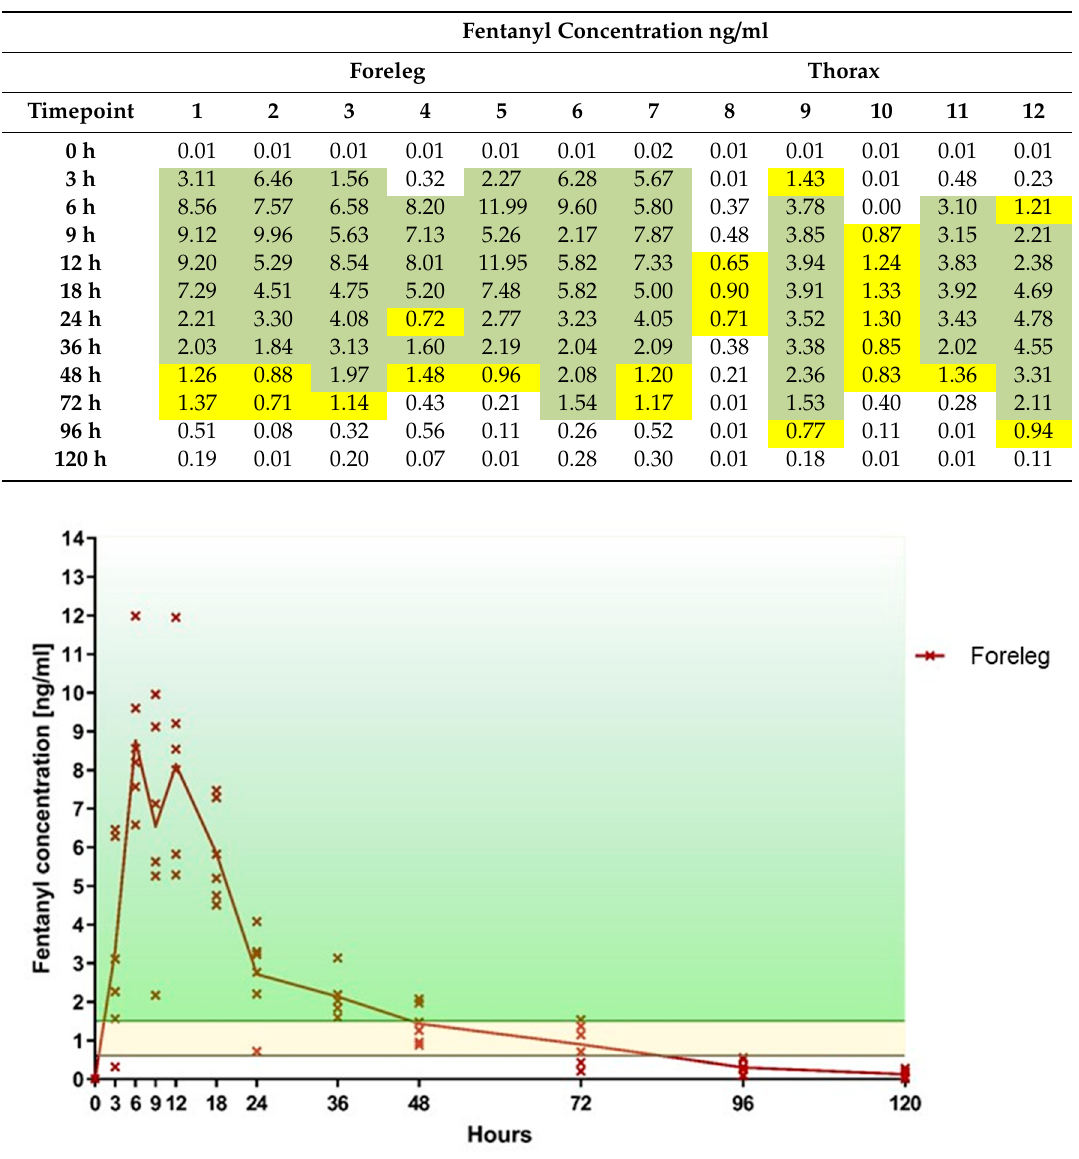
Table 1. Fentanyl plasma level of both groups (values marked in yellow are above 0.6 ng / mL; values marked with green are above 1.5 ng / mL; every column represents one sheep).